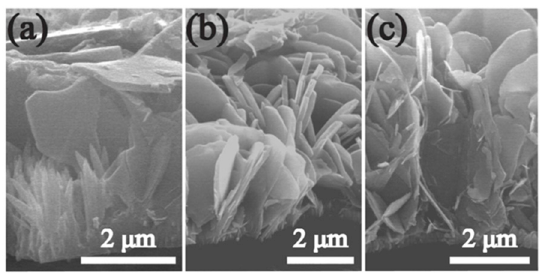
Figure 19. SEM micrography of the ZnO nanostructures side view where both nanoflakes and nanorods can be identified in the same structure. Side-view SEM images of represented AZO nanostructures ( a ) AZ1, ( b ) AZ2 and ( c ) AZ4. [77]. Reprinted from an open-access source.